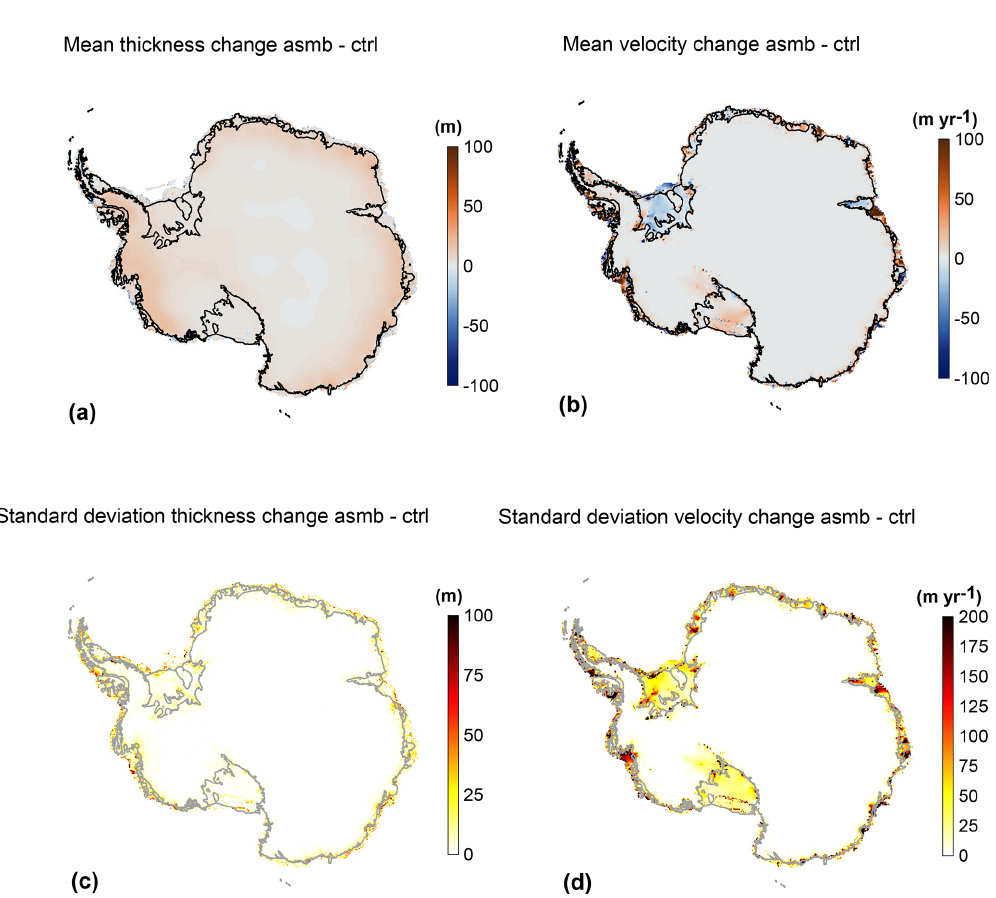
Figure 8. Mean (a, b) and standard deviation (c, d) of the ice thickness ( a and c , in m) and depth-averaged horizontal velocity ( b and d , in myr − 1 ) between the end of the asmb experiment and the end of the ctrl experiment. Black (a, b) or grey (c, d) lines show the current observed ice front and grounding line positions.